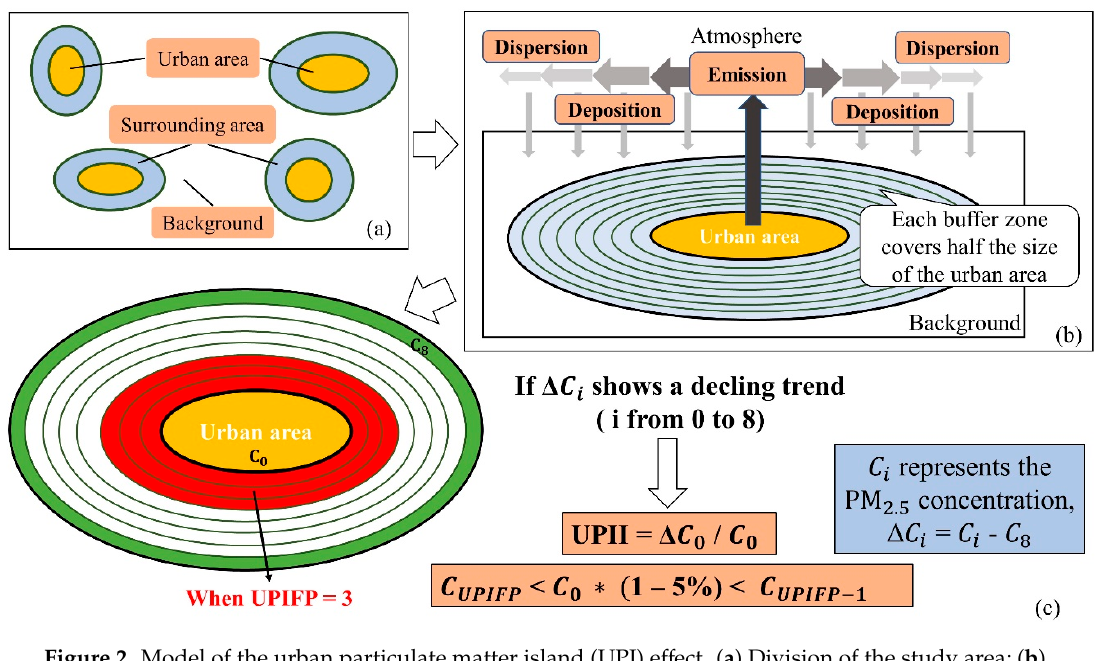
Figure 2. Model of the urban particulate matter island (UPI) effect. ( a ) Division of the study area; ( b ) the three processes of particulate emission, dispersion, and deposition; ( c ) evaluation criterion and two metrics of the UPI